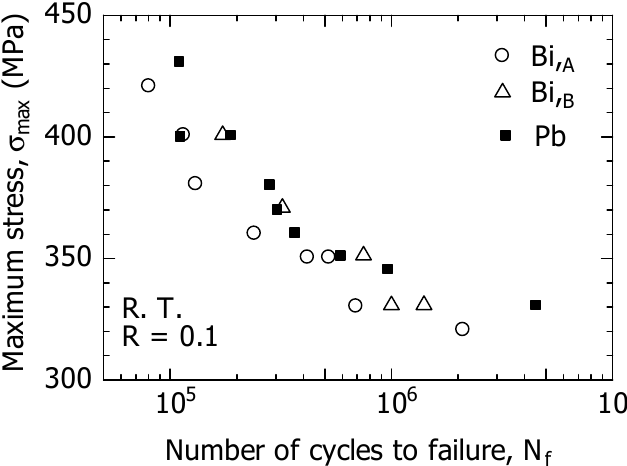
Figure 5. σ max – N f relations for Bi, A , Bi, B , and Pb materials at f = 15 Hz and R = 0.1.